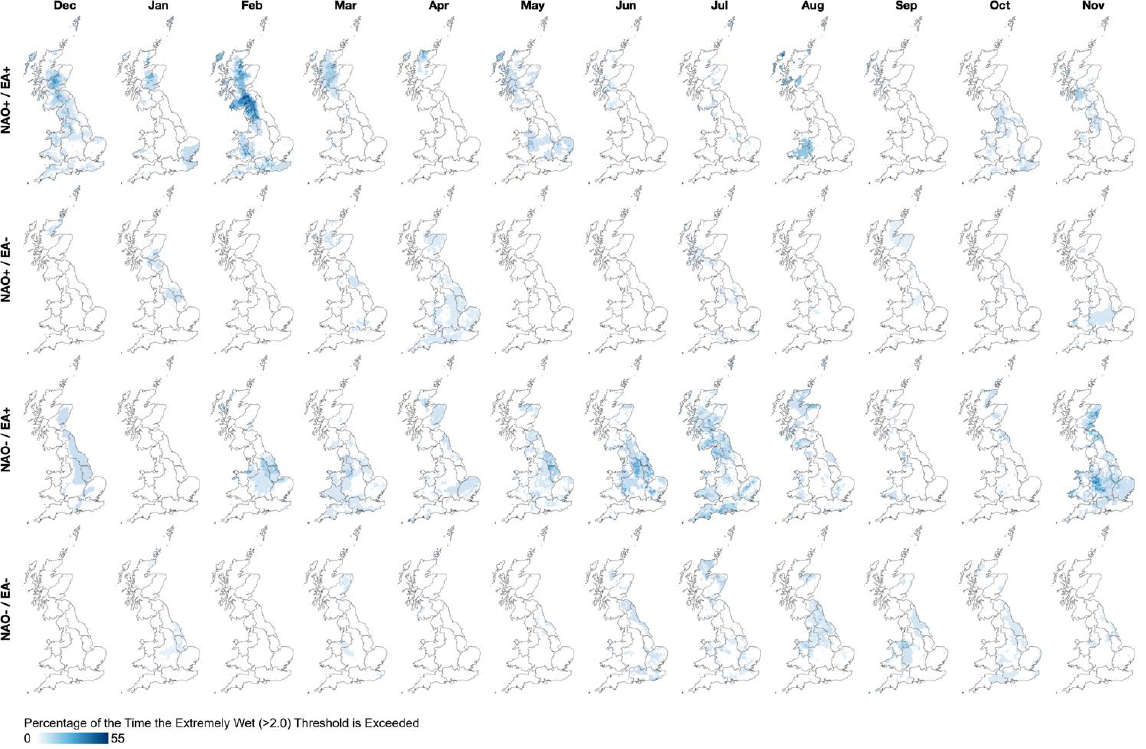
Figure 9. As per Figure 7 but for the extremely wet (SPI-1 > 2.0) SPI-1 class.